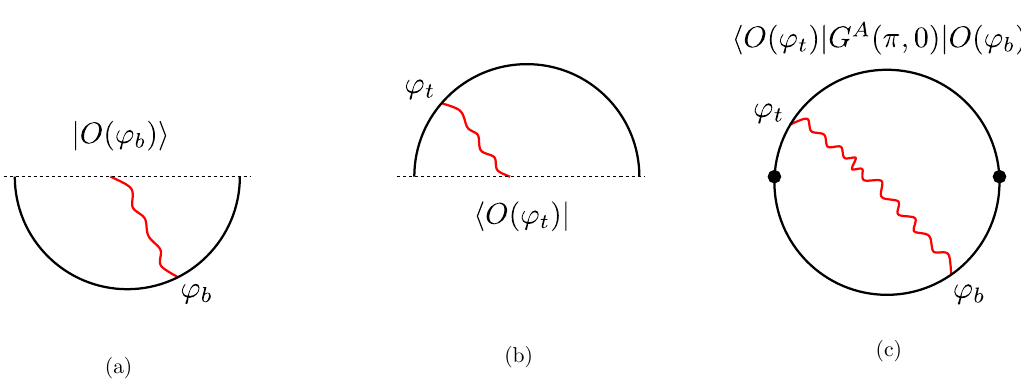
Figure 3 . (a) By performing euclidean evolution over time (cid:12)= 2 and inserting an operator at some point during the euclidean evolution we create a state. This de(cid:12)nes a map between operators and states. These are states of a wormhole or states living in the Hilbert space of two copies of the dual boundary quantum system. (b) The same for the bra. (c) We can take the inner product and add the action of a charge G A ( (cid:25); 0), represented by the black dots. In the semiclassical regime, these charges act as SL(2) generators on the states or the